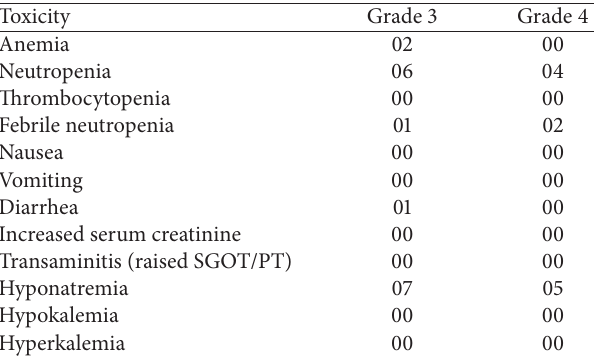
Table 3: Adverse events in accordance with CTCAE version 4.03 observed during NACT. Numbers shown are actual